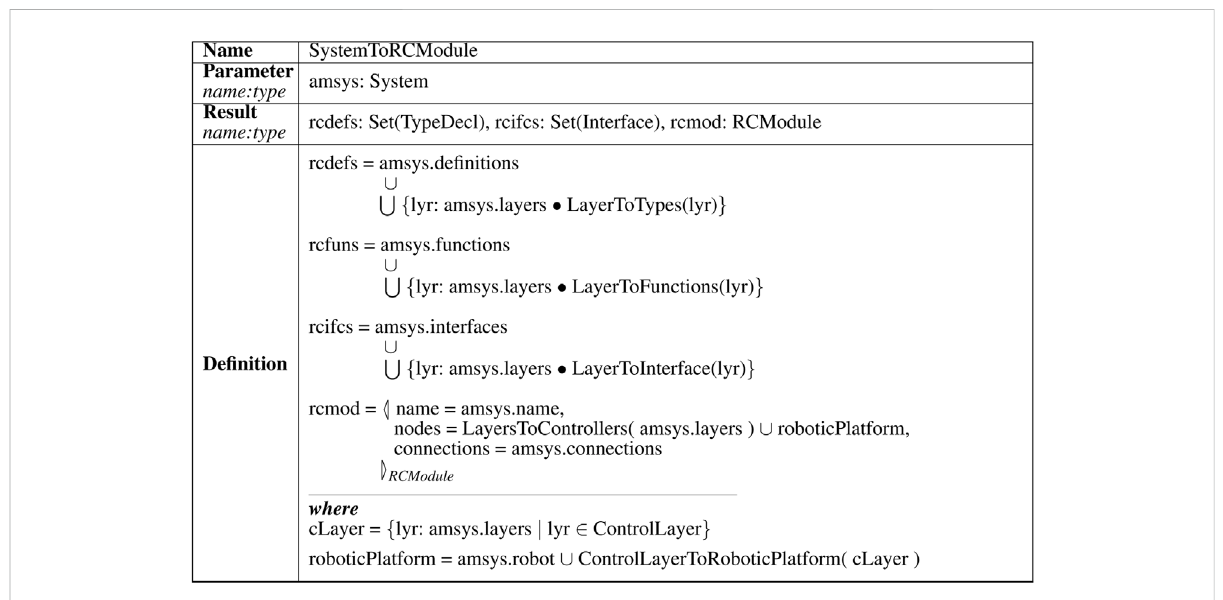
FIGURE 5 Example transformation